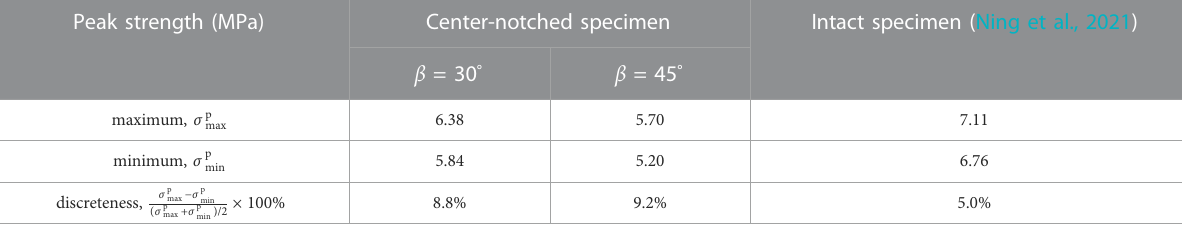
TABLE 2 Peak strength discreteness of rectangular specimens ( m = 5). Peak strength